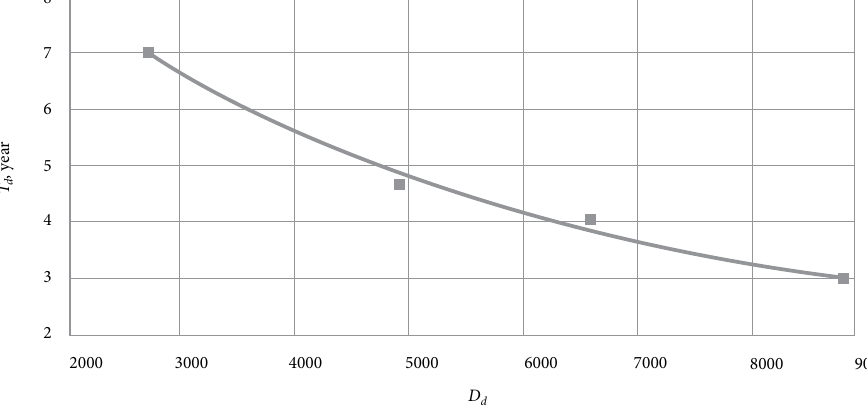
fig. 4. Dependence of minimal value of Т d from D